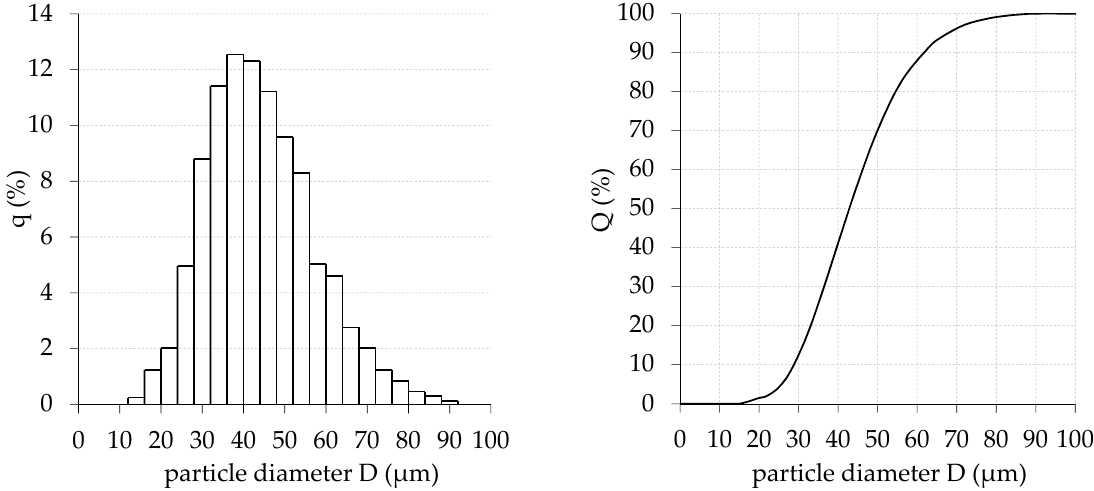
Figure 1. Measured particle sizes of the AISI 316L powder feedstock with frequency distribution q ( left ) and cumulative distribution Q ( right ).